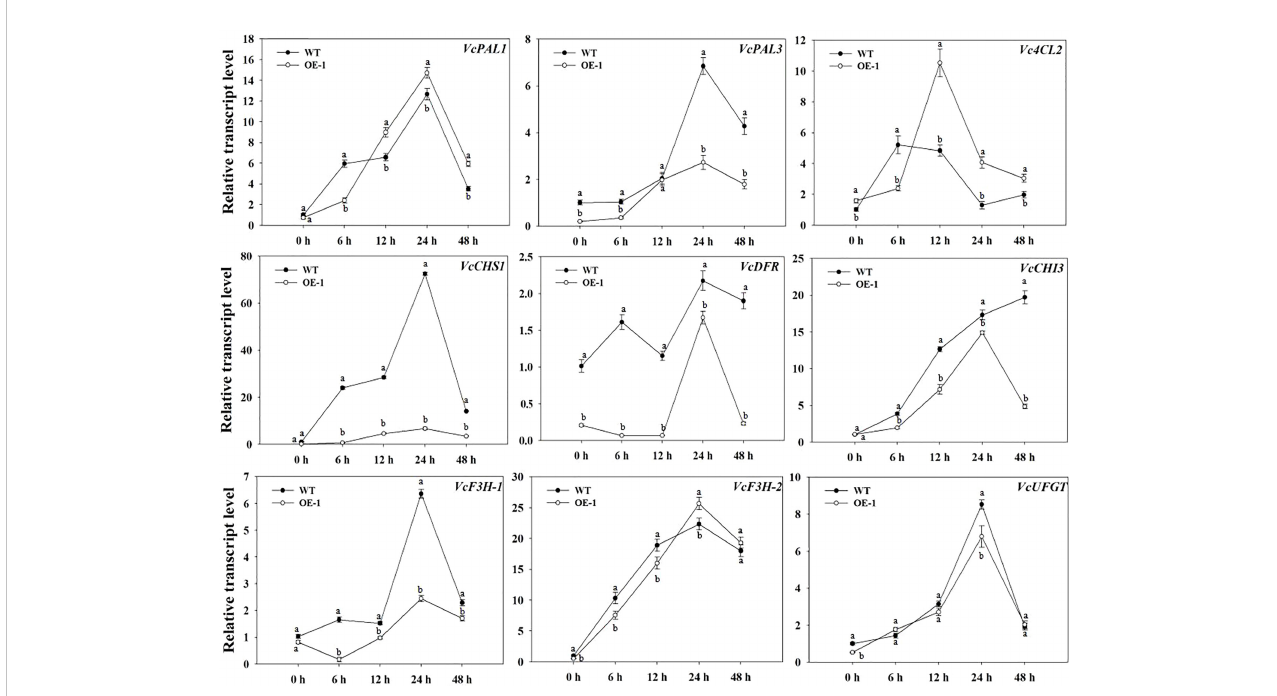
FIGURE 5 Expression of anthocyanin biosynthesis genes was repressed in the VcMYB4a- overexpressing blueberry calli (OE-1) compared with that in wild-type (WT) calli under UV-B treatment. Error bars indicate ± SD of the mean of three independent biological replicates, each with three technical replicates; different letters indicate signi fi cant differences ( p < 0.05) among samples by Tukey ’ s test.